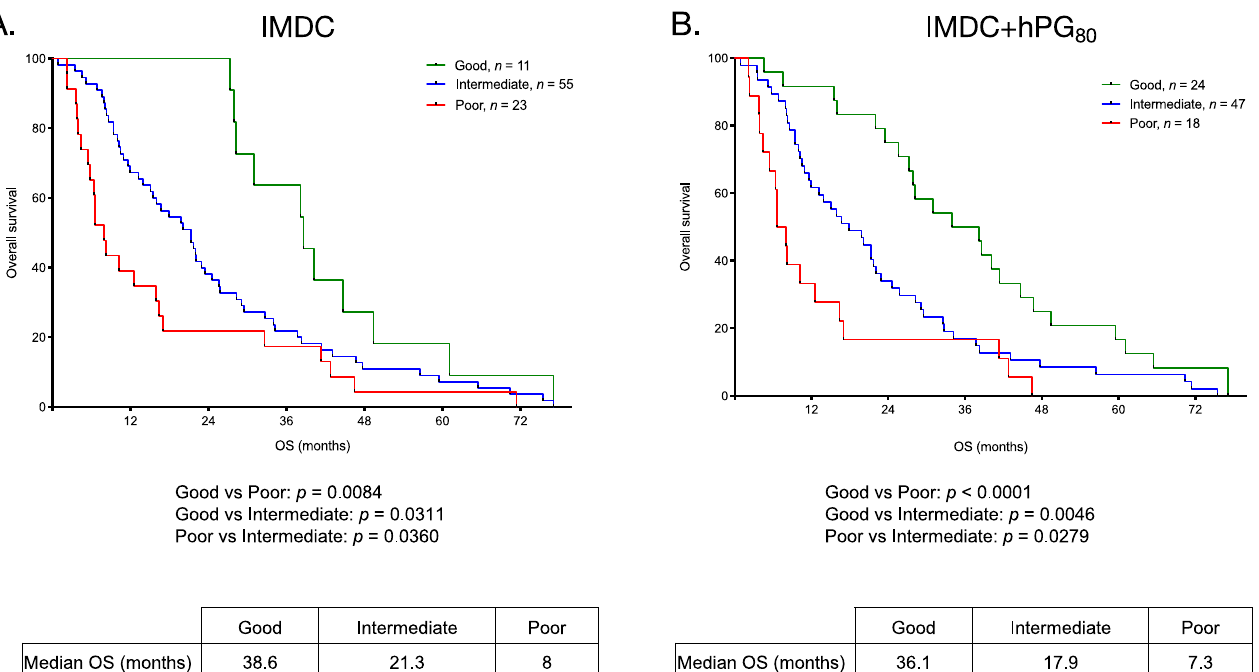
Figure 5. Overall survival according to the IMDC score and to a model incorporating IMDC variables and hPG 80 levels. ( A ). Kaplan-Meier analysis of overall survival (OS) for mRCC patients according to the IMDC risk classification (good, intermediate, poor). ( B ). Kaplan-Meier analysis of OS for mRCC patients with a model combining IMDC variables and hPG 80 levels. The median OS (in months) and the p values from the log-rank test are indicated.